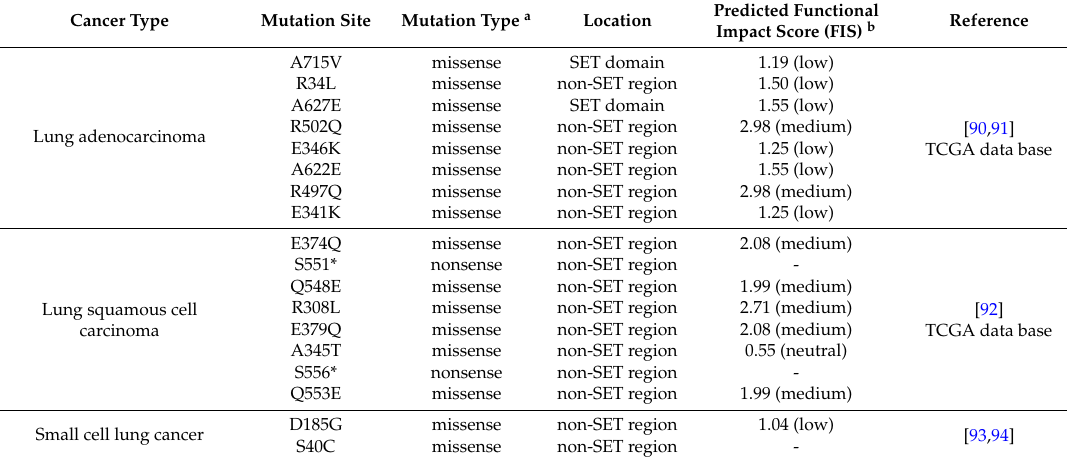
Table 5. The characteristics of EZH2 mutations in different cancer